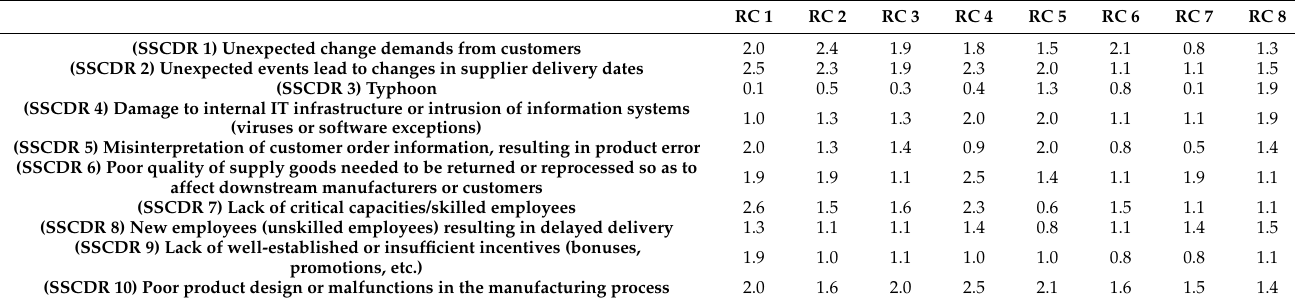
Table 6. Relational matrix of SSCDRs and RCs (R M ).